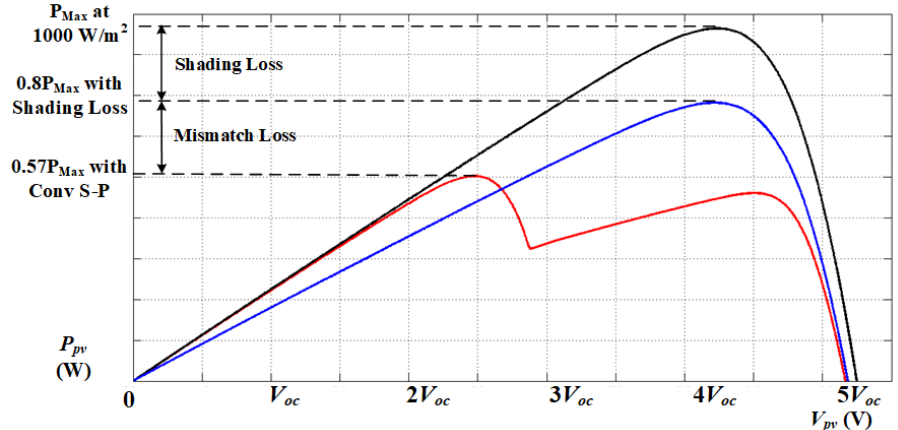
Figure 2. An illustration of I–V curves showing the distinction in power due to loss of shading and loss of mismatch .